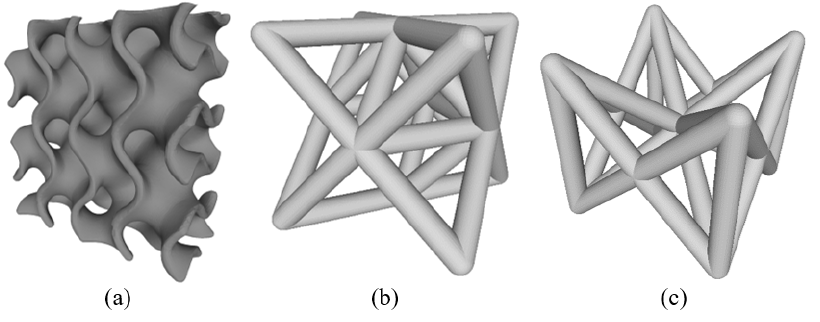
Figure 1. Topological cell of reinforcement—gyroid ( a ), octet-truss ( b ) and FBCCZ ( c